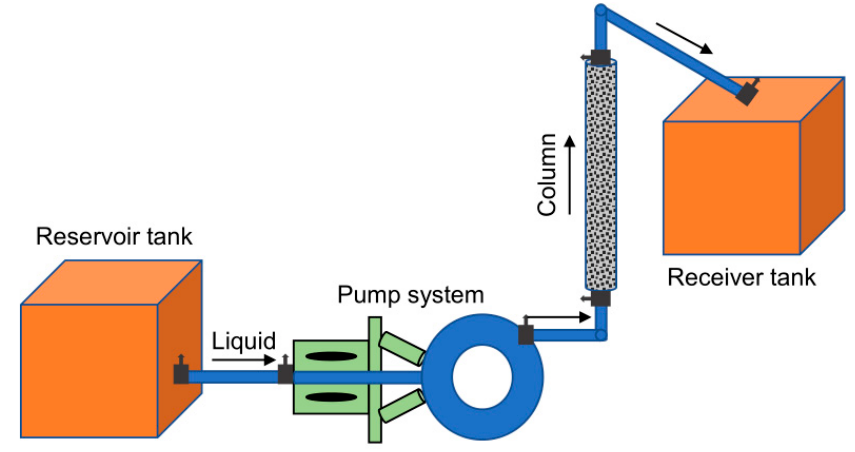
Figure 1. Experimental schematic diagram of the column.